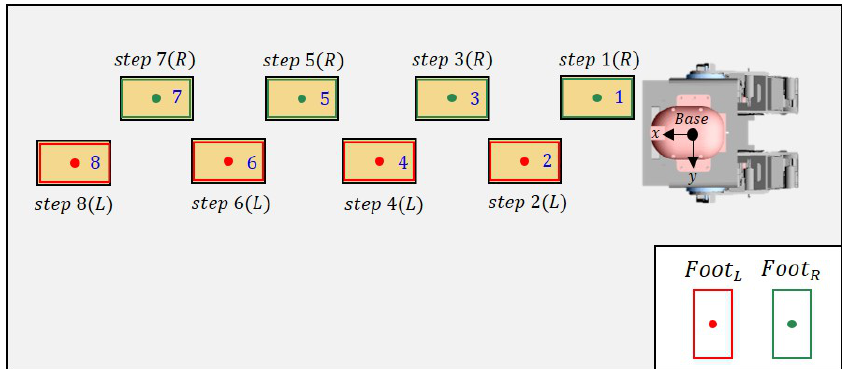
Figure 12. Top view of Scene